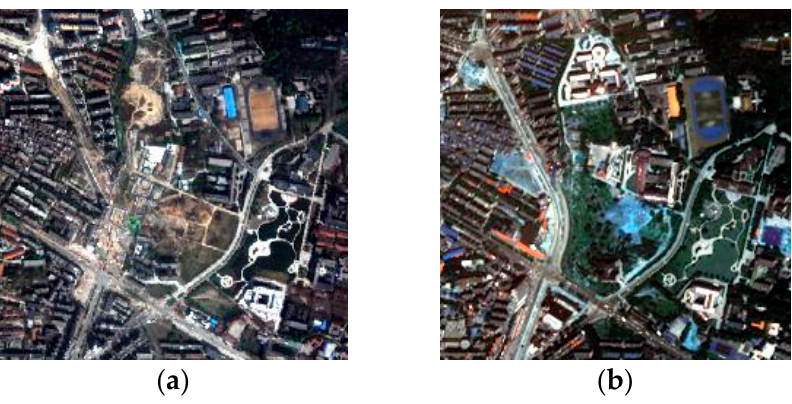
Figure 12. Preprocessed bi-temporal images of the second study area: ( a ) acquired by QuickBird in May 2002 (L1) and ( b ) acquired by IKONOS in July 2009 (L2). Table 6. Comparison between the change detection results of the three thresholding and clustering methods, with L2 as the basis image in the second study area (scale = 50).